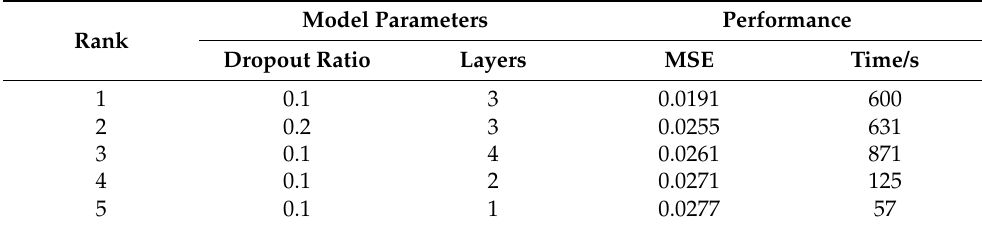
Table 2. Dropout ratio and network depth performance.